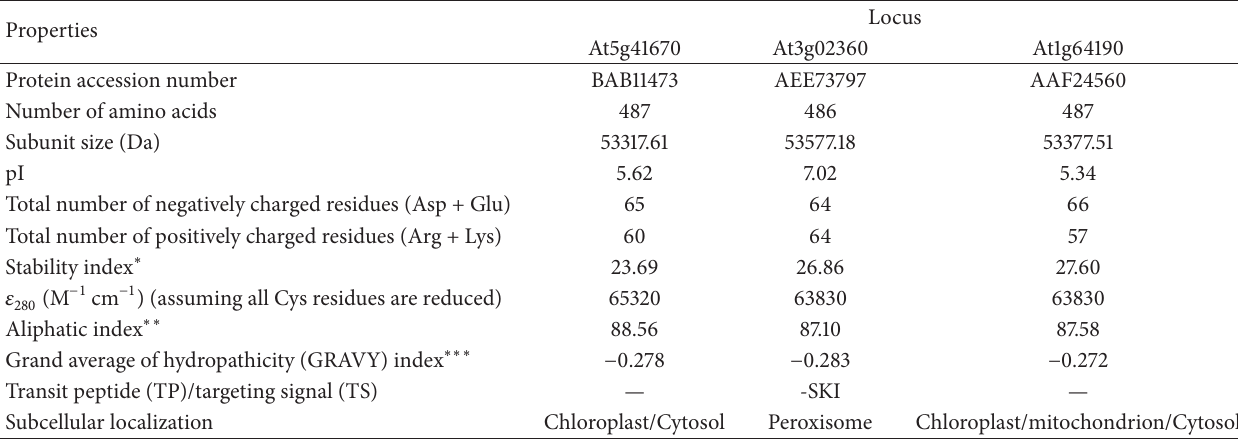
Table 2: Genes encoding different isozymes of 6PGDH in A. thaliana and molecular properties based on their predicted amino acid sequence. The number of amino acids corresponds to the preprocessed protein and they were used for the in silico predictions